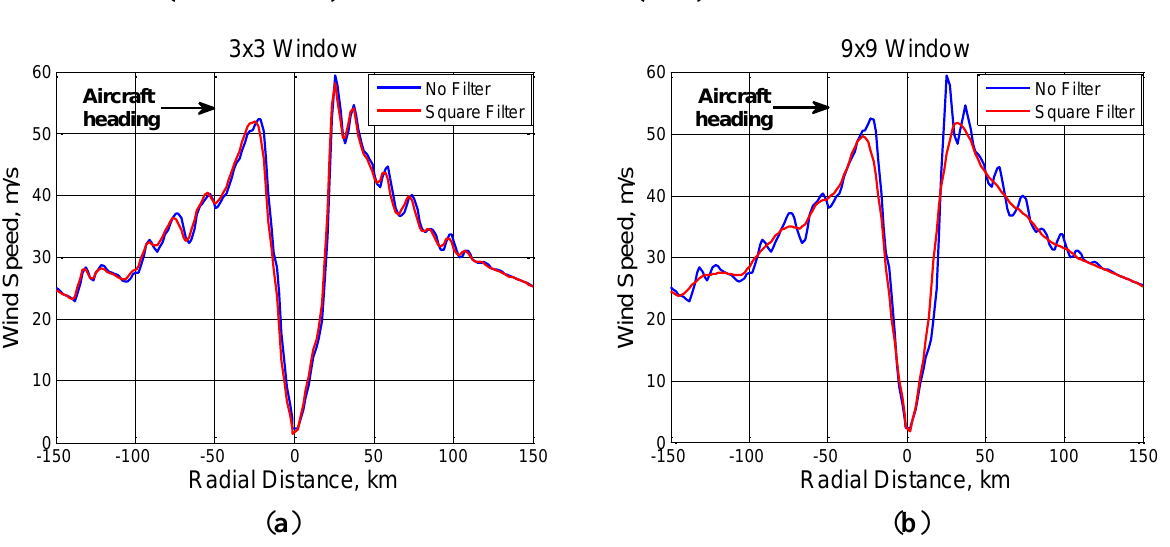
Figure 2. The ground track wind speed for: (a) 3 × 3 and (b) 9 × 9 square spatial filter windows (shown in red) and the unfiltered wind